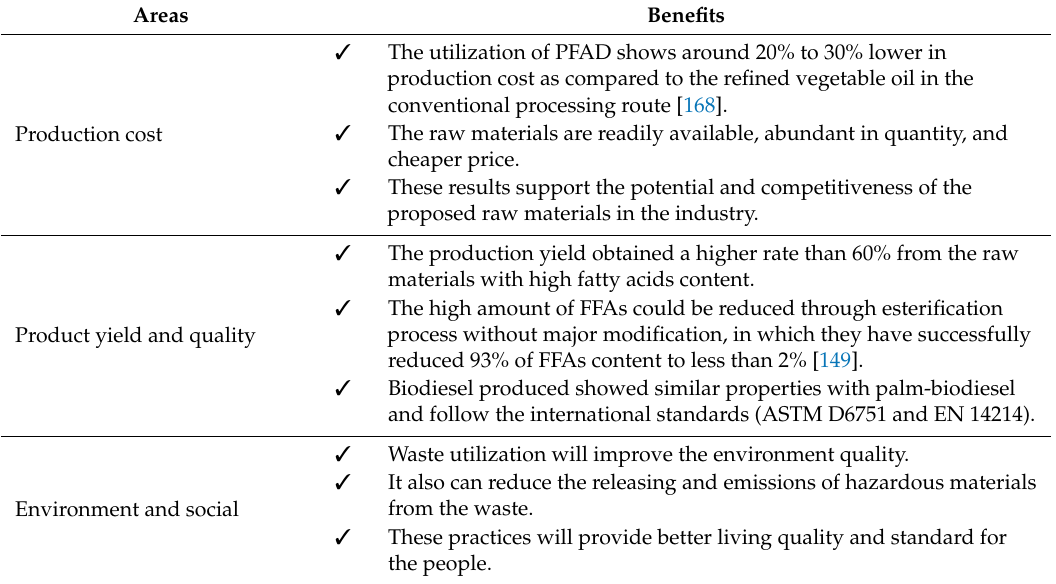
Table 12. Benefits of utilization palm oil by-products and mill effluent in biodiesel production.